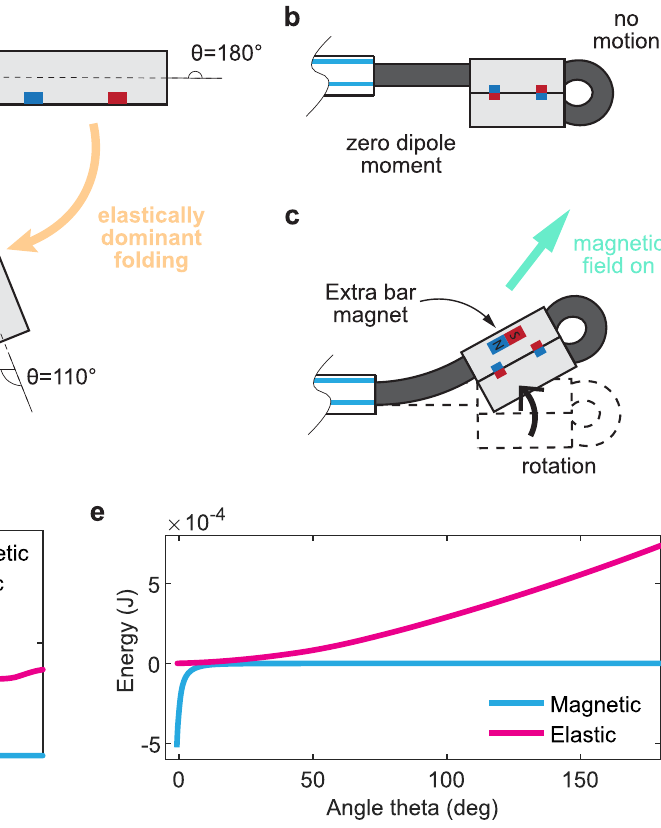
Fig. 2 | A smooth folding process with a combination of elastic and magnetic energies. a An illustration of a typical folding process. The free rigid segment is folded from the initial position ( θ =180°) to the fi nal assembly position ( θ =0°). From the initial position, the folding process is dominated by the elastic torque untilitisclosetothe fi nalassemblyposition( θ =20°)wheretheassemblymagnets close. b , c Demonstrationofthezerodipolemomentfortheassemblymagnetsthat